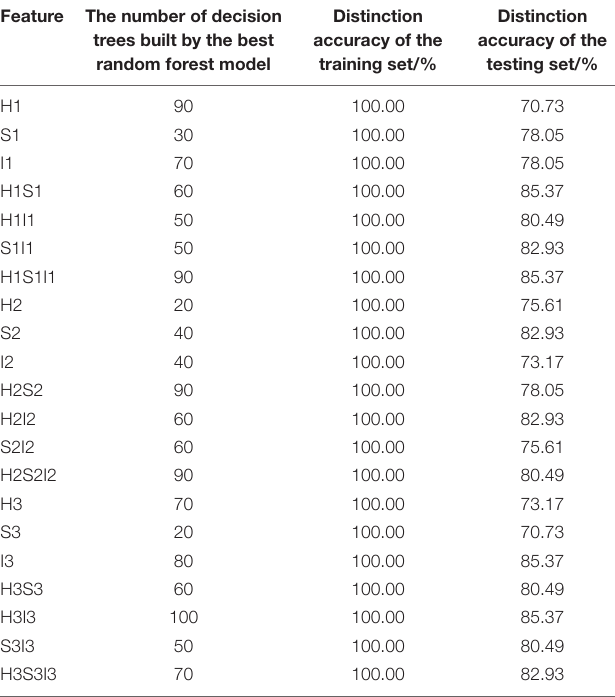
TABLE 6 | Distinction results of the random forest models based on the LBP histogram features of the gray images of the three components in the HSI color space of the segmented lesion images.